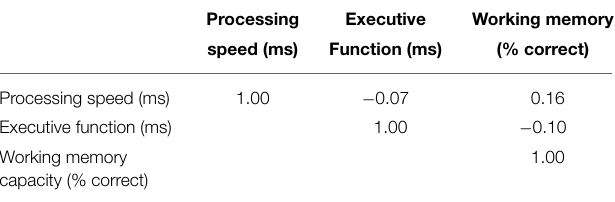
TABLE 1 | Pearson product-moment correlations between cognitive measures.